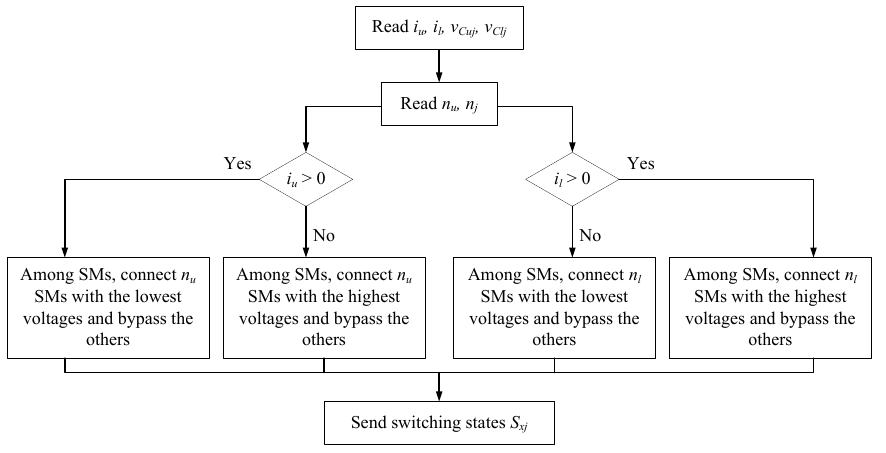
Figure 3. Conventional sorting algorithm.